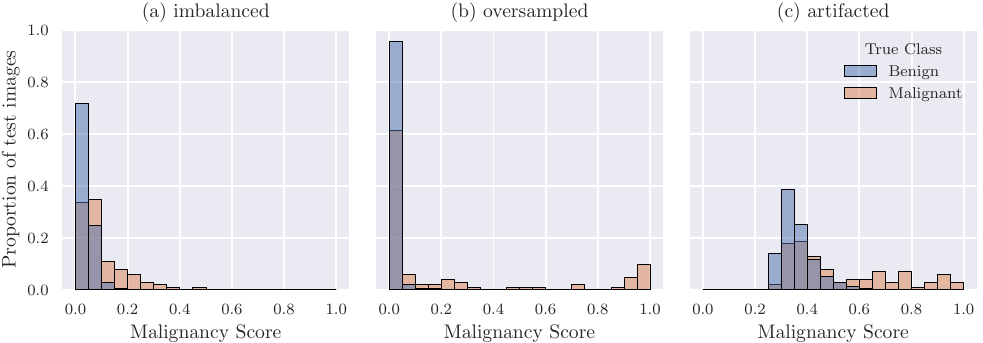
Figure 2. Distributions of predictions for selected models, trained on D VinDR D VinDR test . Malignancy score is the softmax output of the model—at an operating point of 0.5, for example, the model would predict malignant for samples above 0.5, and benign for those below. The distributions in the plot are normalised so that bar heights sum to 1 for each class in each